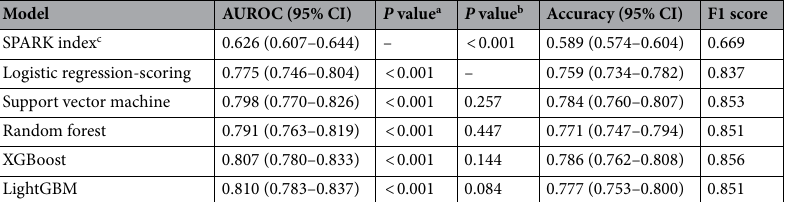
Table 2. Comparison of models for predicting postoperative acute kidney injury after nephrectomy. AUROC area under the receiver operating characteristic curve, CI confidence interval, SPARK simple postoperative AKI risk, XGBoost extreme gradient boosting, LightGBM light gradient boosting machine. a Compared with the SPARK index. b Compared with the stepwise logistic regression model. c The optimal cut off value was 29.5 in the present dataset.